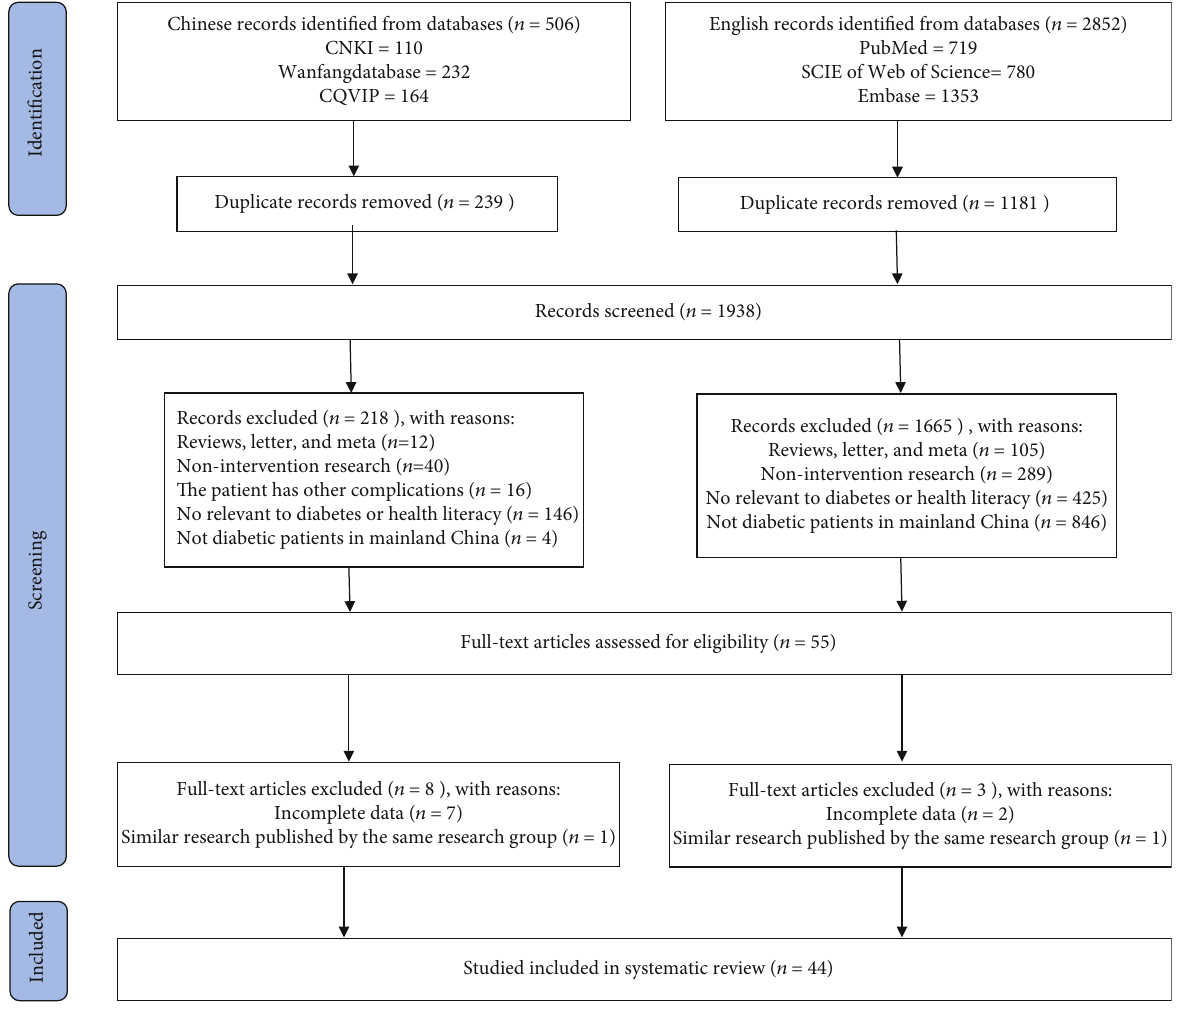
Figure 1: Article selection